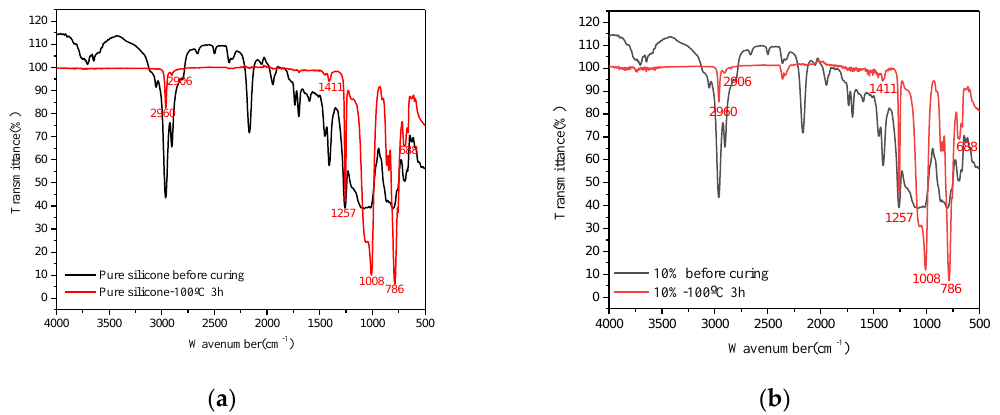
Figure 8. FTIR results of ( a ) pure silicone and ( b ) phosphor/silicone composites before and after curing at 100 °C for 3 h. Polymers 2019 , 11 , 1277 8 of 16